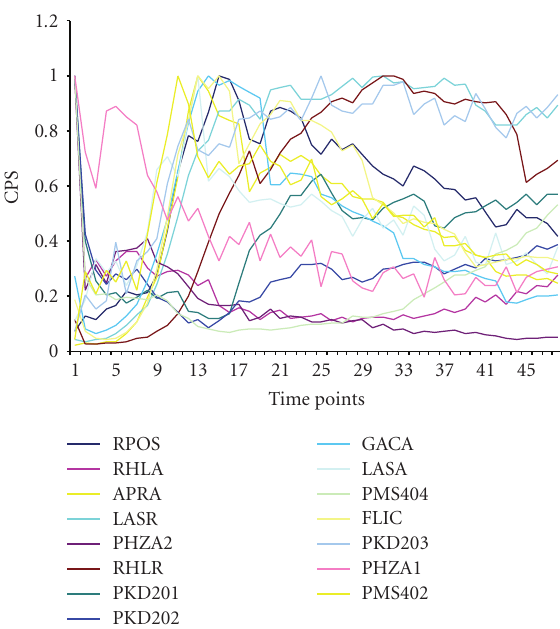
Figure 1: The trajectories of the 15 gene-set in C1T13: TSBDC condition.